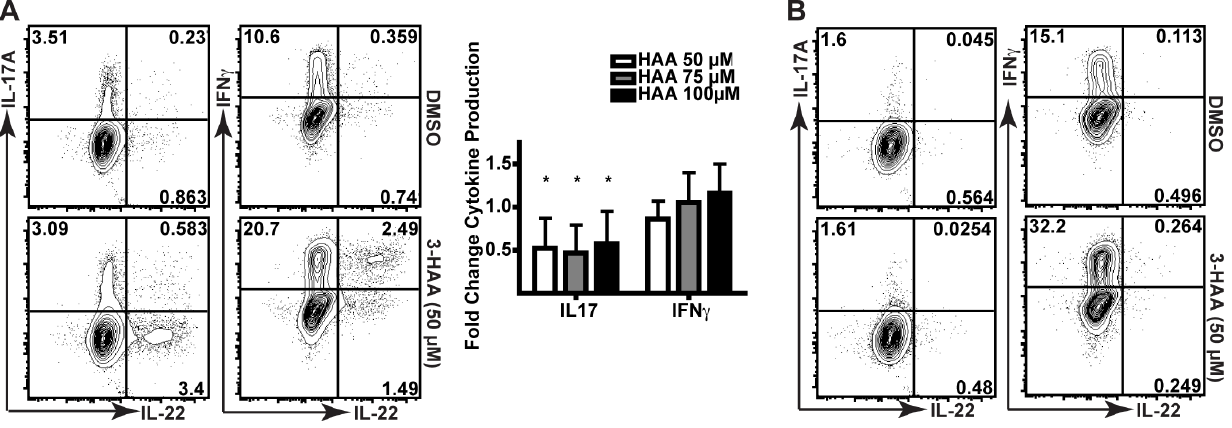
Figure 2. IL-22 + upregulation occurs in CD4 + 8 - T cells that are IL-17 negative but express IFN c . (A) Cytokine production for live CD3 + CD4 + CD8 2 T cells from human PBMC cultures that were stimulated with anti-CD3 and anti-CD28 antibodies and allogeneic APCs for six days with DMSO or 50 m M 3-HAA. Panel (right) depicts fold-changes in 9 donors relative to DMSO. *, p , 0.05 indicates data analyzed by Wilcoxon signed rank test is statistically different than 1. (B) Cytokine production for live CD3 + CD8 + CD4 2 T cells in PBMC cultures, stimulated as above with DMSO or 3- HAA (50 m M). Data are representative of three experiments.